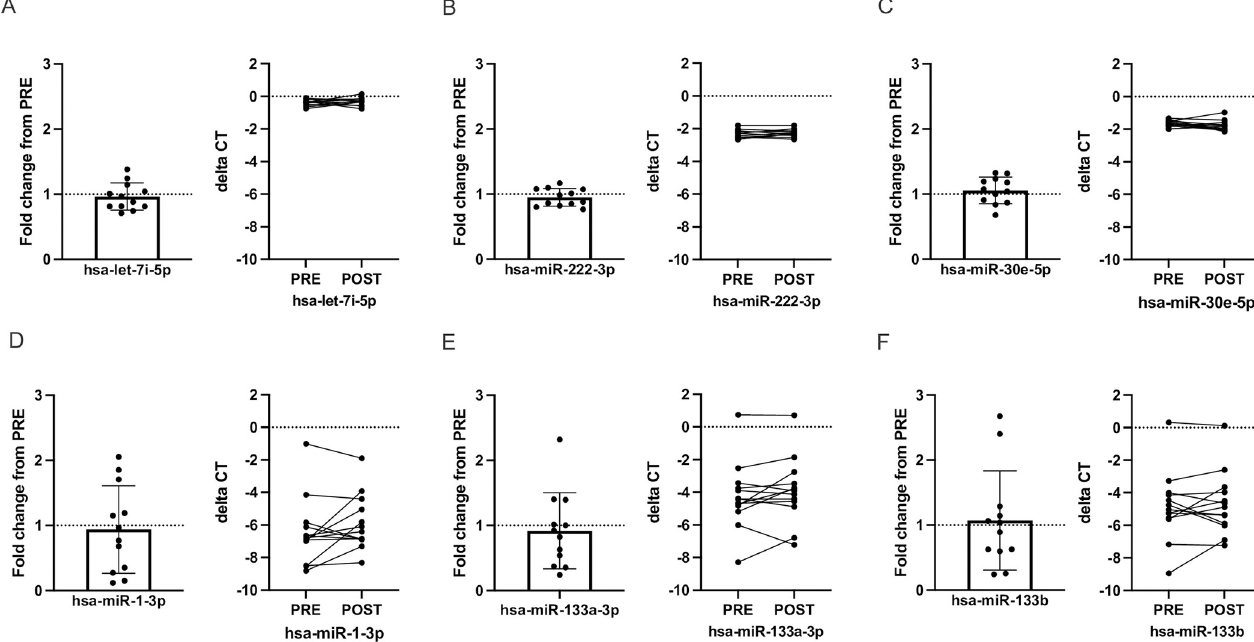
Fig 4. Effect of prophylactic tinzaparin treatment on quantification of different endogenous circulating miRNAs in fracture patients. Effect of a dose of tinzaparin ( < 6 hours) on levels of hsa-let-7i-5p (A), hsa-miR-222-3p (B), hsa-miR-30e-5p (C), hsa-miR-1-3p (D), hsa-miR-133a-3p (E) & hsa-miR-133b (F) in plasma. Data expressed as fold change from PRE (left graph) and delta CT pre vs post (right graph), mean ± SD, n = 12.